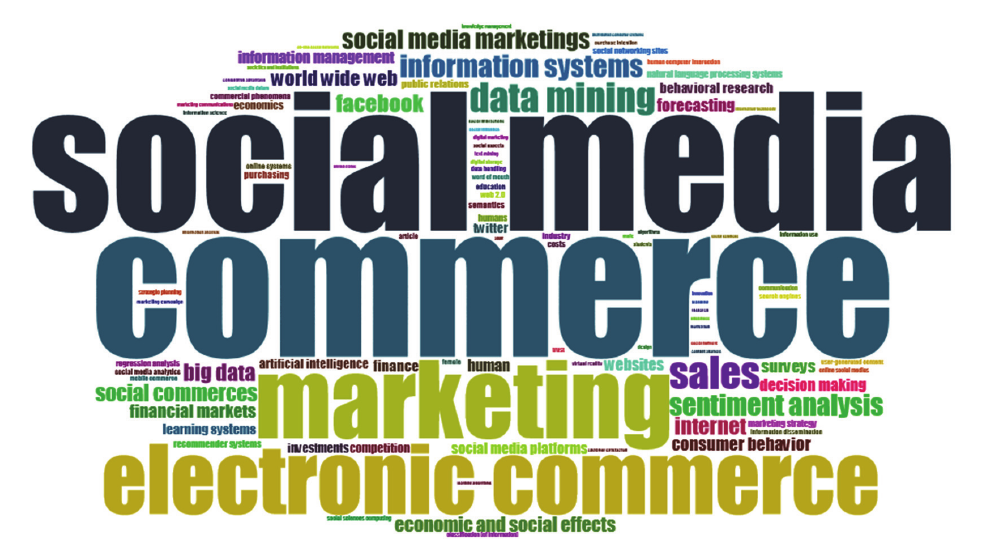
Fig. 2. The frequency of the keywords used in different